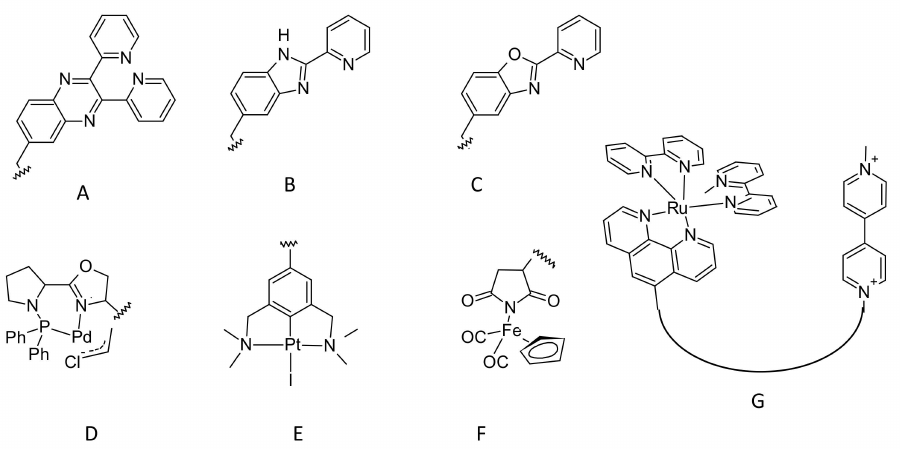
Figure 9. Selected examples of structures discussed in the text. Nonproteinaceous amino acid heterocyclic side chains: Substituted quinoxaline ( A ), benzimidazole ( B ), and benzoxazole ( C ). Coordination motives: Phosphine-oxazoline palladium complex ( D ), terdentate, monoanionic pincer platinum(II) complex ( E ), cyclopentadienyl iron dicarbonyl unit ( F ). Fluorophore ruthenium(II) bis-bipyridine-phenanthroline and methyl viologen quencher set ( G